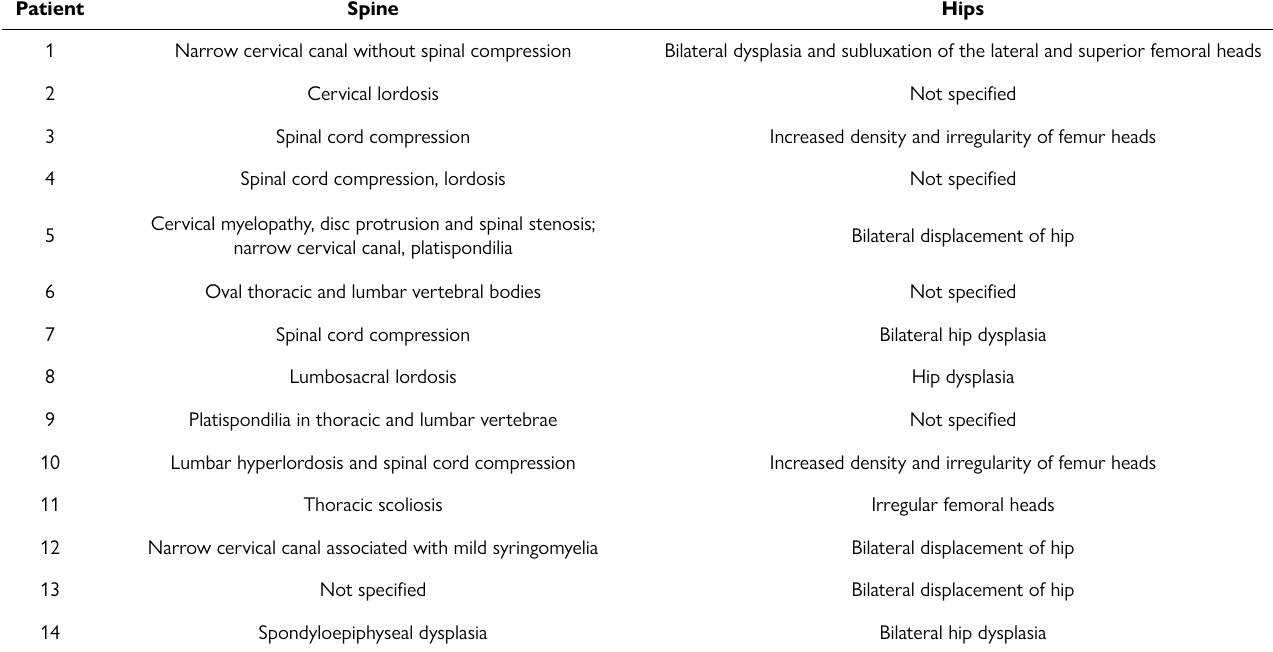
Table 3 – Outcomes of orthopaedic imaging in the study cohort